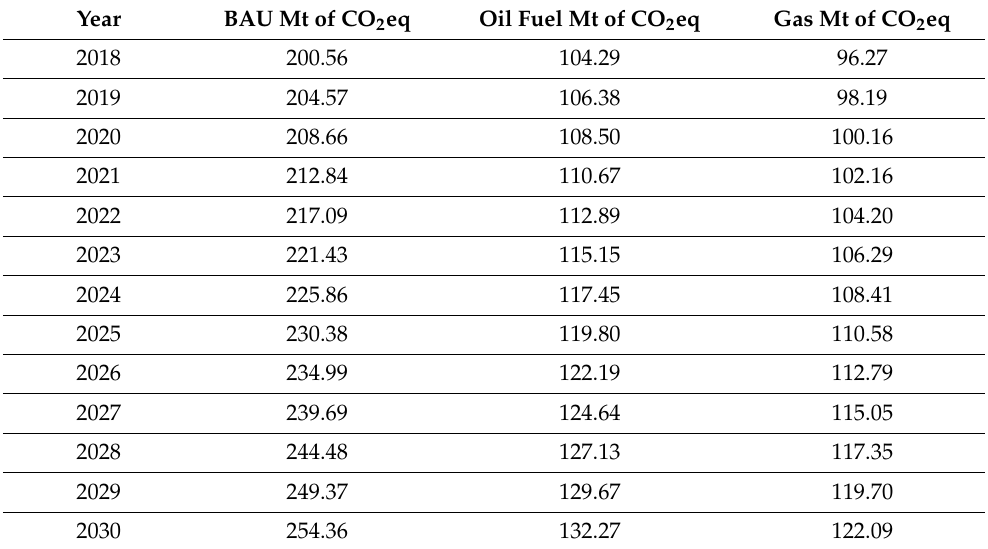
Table 1. GHG emissions forecast from electricity generation under a BAU